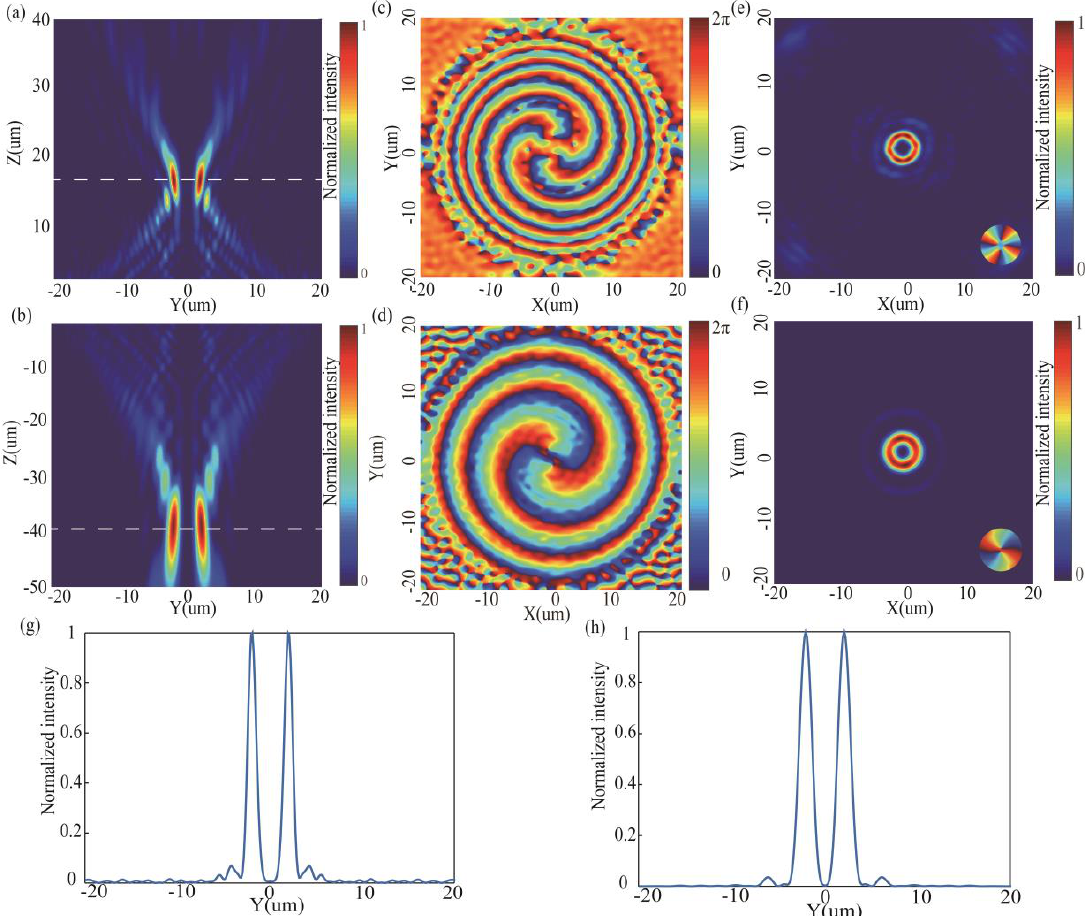
Figure 5. ( a , b ) Simulated intensity profiles on the y-z cross section for the MSF generator in reflection mode ( l = 4) and in transmission mode ( l = 2), respectively. ( c , d ) Simulated phase distribution of reflected light and transmitted light at one wavelength away from exit facet of the MSF generator, respectively. ( e , f ) Reflected focal ring and transmitted focal ring of the MSF generator at focal plane (z = 17.2 µ m and z = − 39 µ m), respectively. ( g , h ) Corresponding vertical cuts of focal ring.